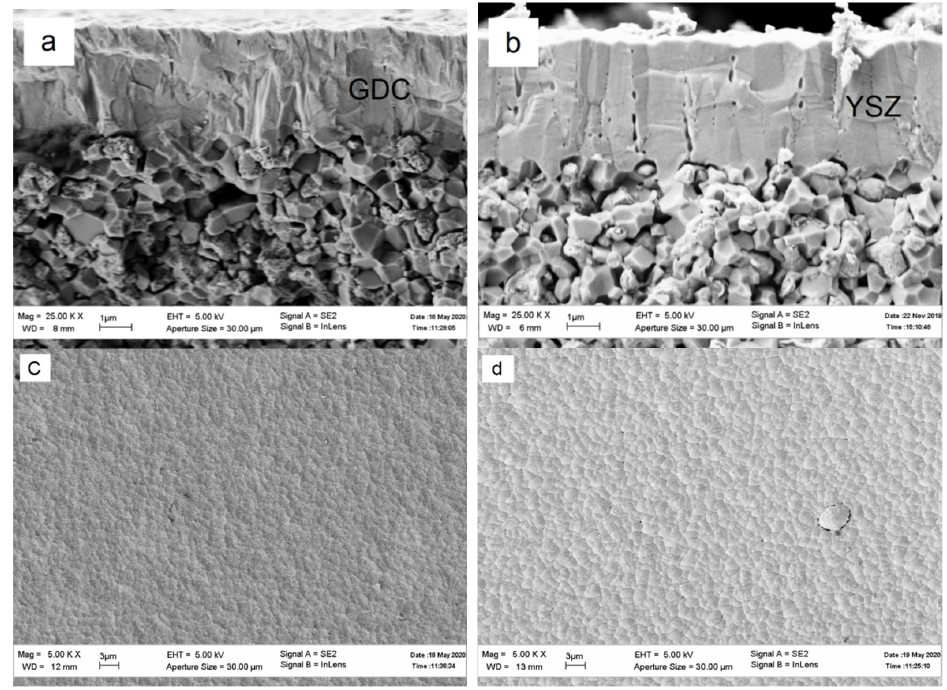
Figure 1. SEM images of the cross sections and surface of the GDC ( a,c ) and YSZ ( b,d ) electrolyte microstructure.